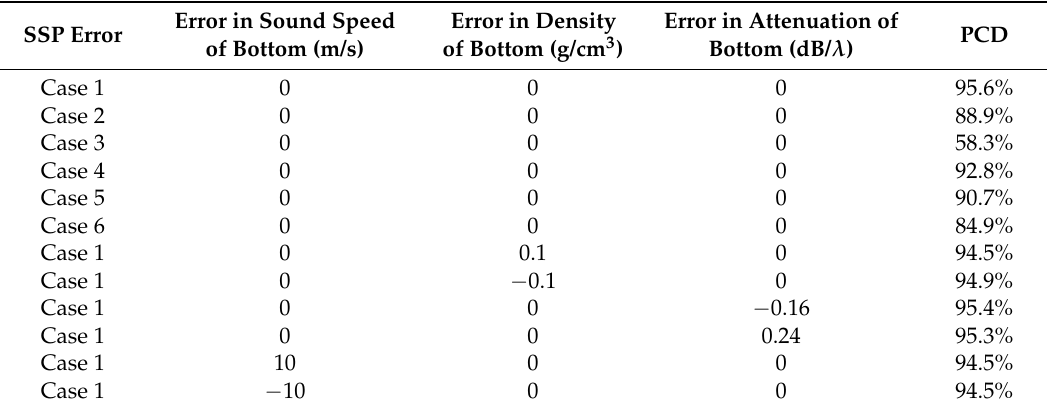
Table 1. Probability of correct discrimination (PCD) in different mismatched environments.